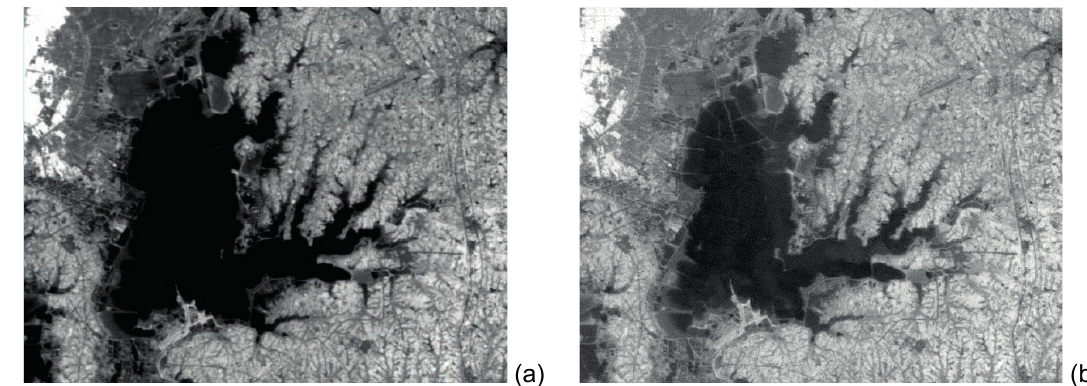
Fig. 4 NDVI comparison between (a) before and (b) after FLAASH atmospheric correction.